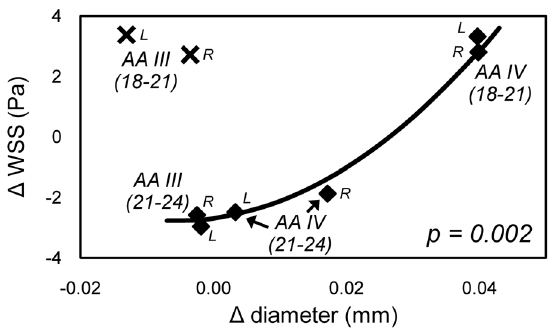
Figure 6. Comparing changes in diameter with changes in WSS from stages 18 to 21 and 21 to 24 for AA III and IV revealed a 2 nd order polynomial relationship (p=0.002). Growth of AA IV from stage 18 to 21 and growth of both AA III and IV from stage 21 to